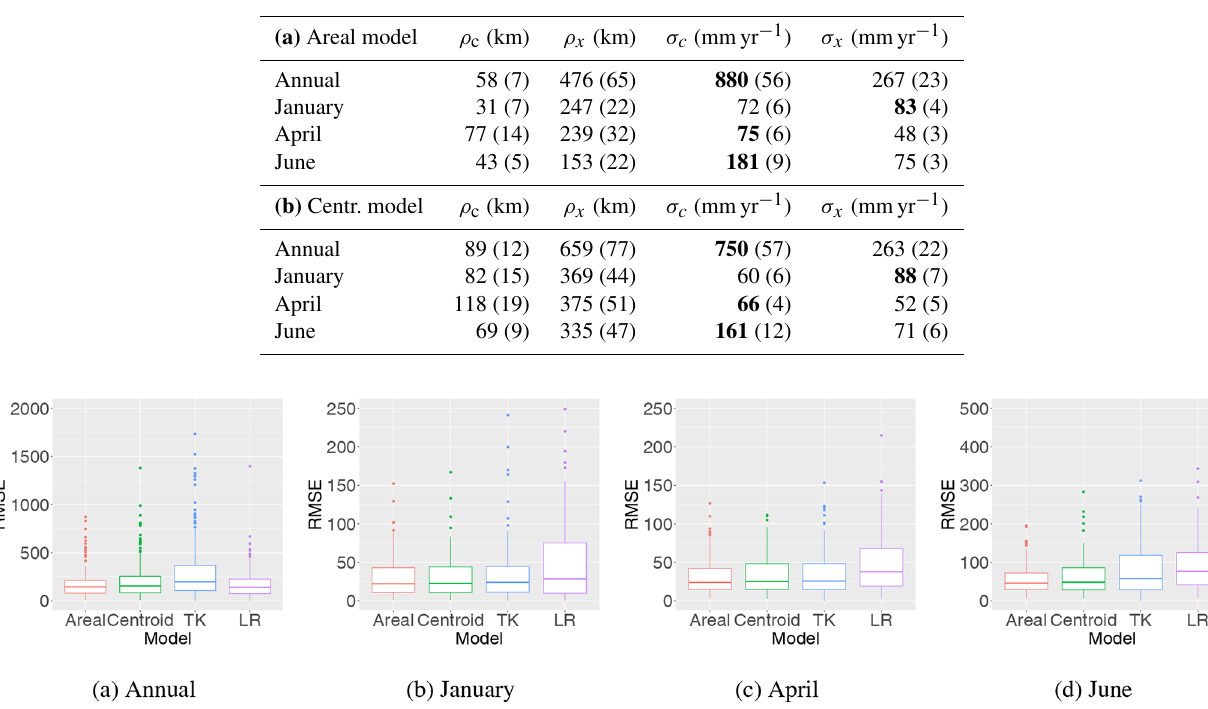
Table 2. The posterior mode of the range parameters ρ c and ρ x and the marginal standard deviations σ c and σ x of the climatic and the annual GRFs c( u ) and x j ( u ) for the areal model (a) and centroid model (b) . The posterior standard deviations of the parameters are shown in parenthesis as a measure of the uncertainty. The mode and standard deviations vary between the experiments and groups in the cross- validation, and the values given here are the mean over all folds and experiments (UG and PG). The spatial effect that dominates (annual or climatic) is marked in bold.